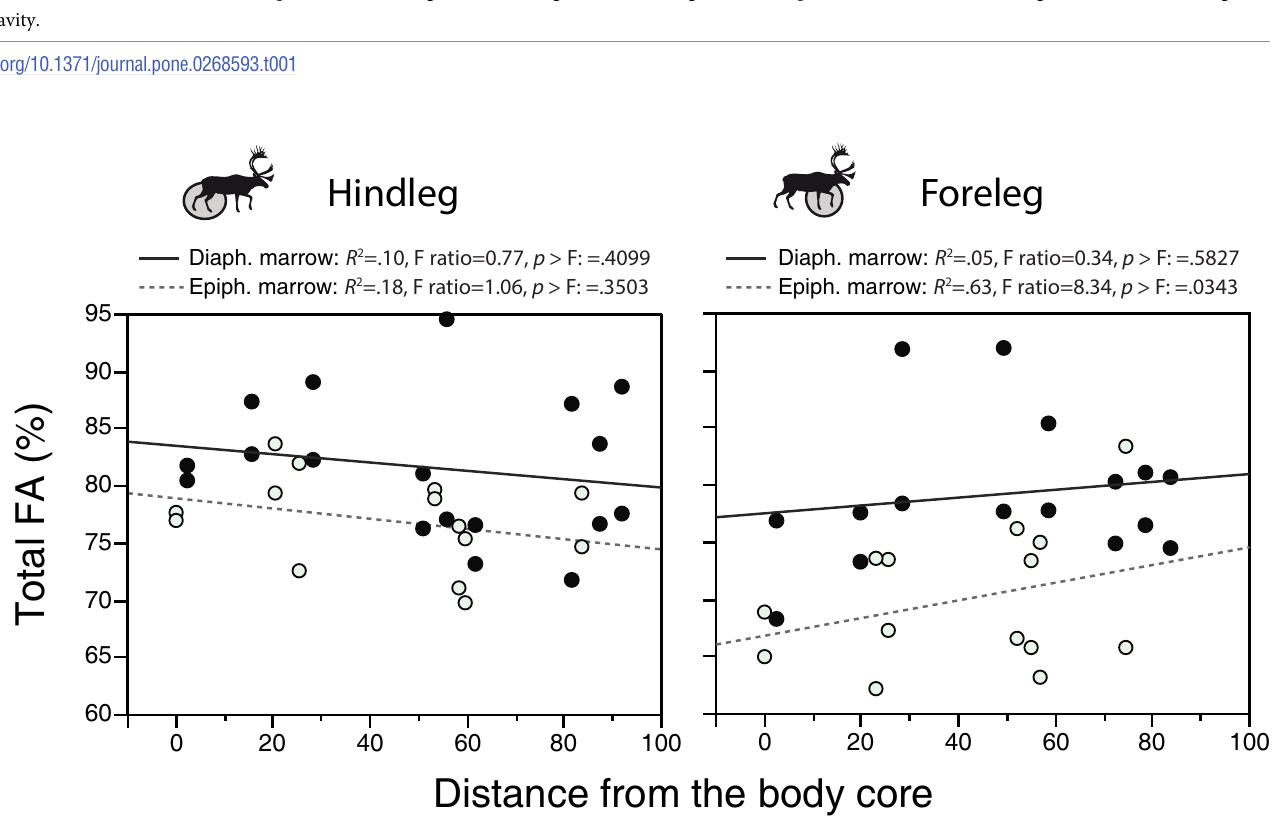
Fig 2. Relationship between the percentage of fatty acid (FA, % of crude fat) and sample distance in the diaphyseal and epiphyseal marrow of caribou. (distance data from S1 Fig; FA data from Table 1 and S1 File). Note that, with the exception of the slope for diaphyseal marrow in the foreleg, none of the slopes in this figure are significantly different from a null model. The regressions were calculated using the average for the two individuals. Closed circles: individual A; open circles: individual